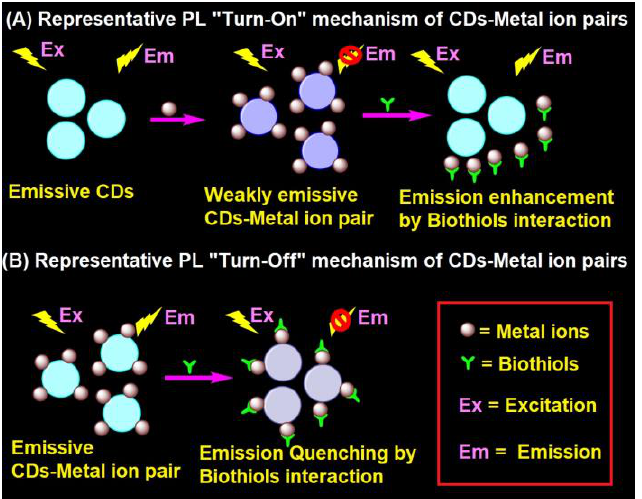
Figure 2. Representative ( A ) PL “Turn - On” and ( B ) PL “Turn - Off” mechanism of the CD – metal ion pair in the biothiols assay. pair in the biothiols